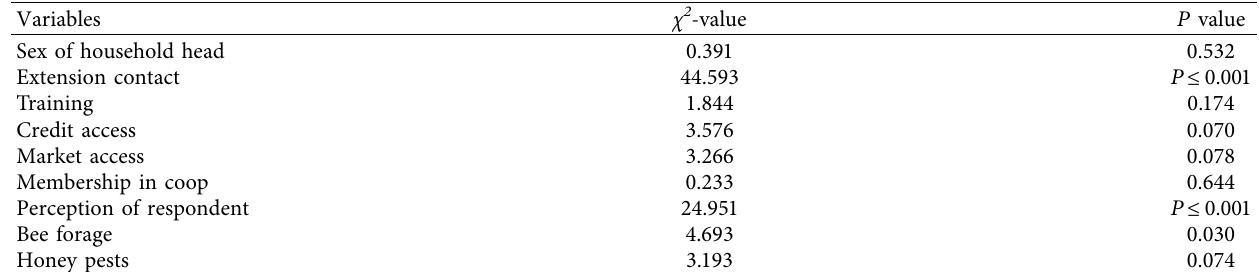
Table 16: Summary of χ 2 -test values for categorical